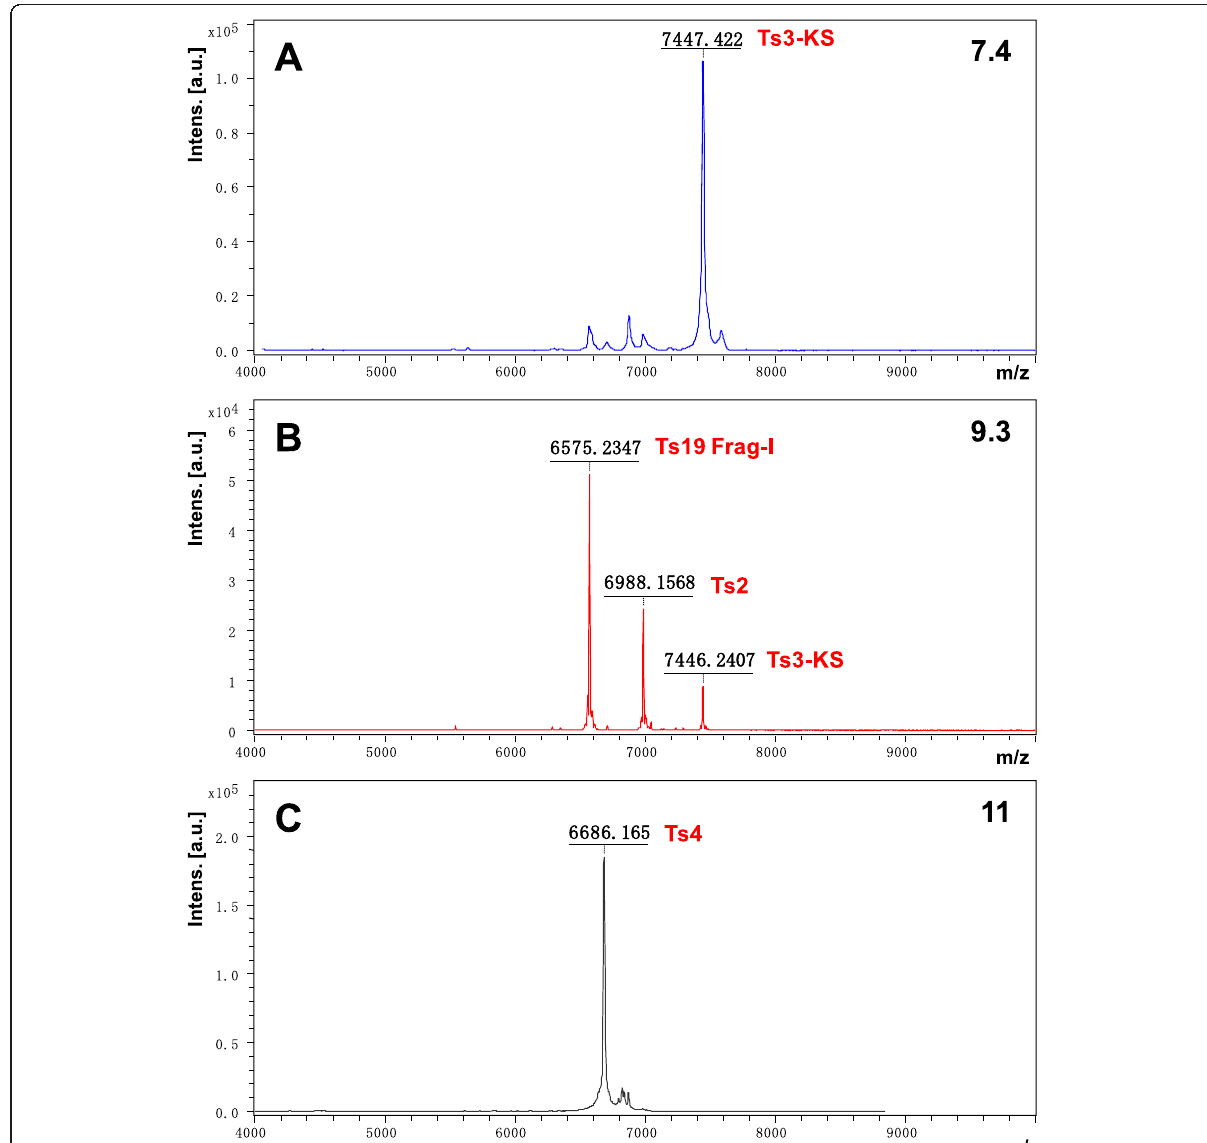
Fig. 3 Mass spectra of the peaks ( a ) 7.4, ( b ) 9.3 and ( c ) 11. The mass spectra were obtained by MALDI-TOF mass spectrometry in a positive linear mode using DHB